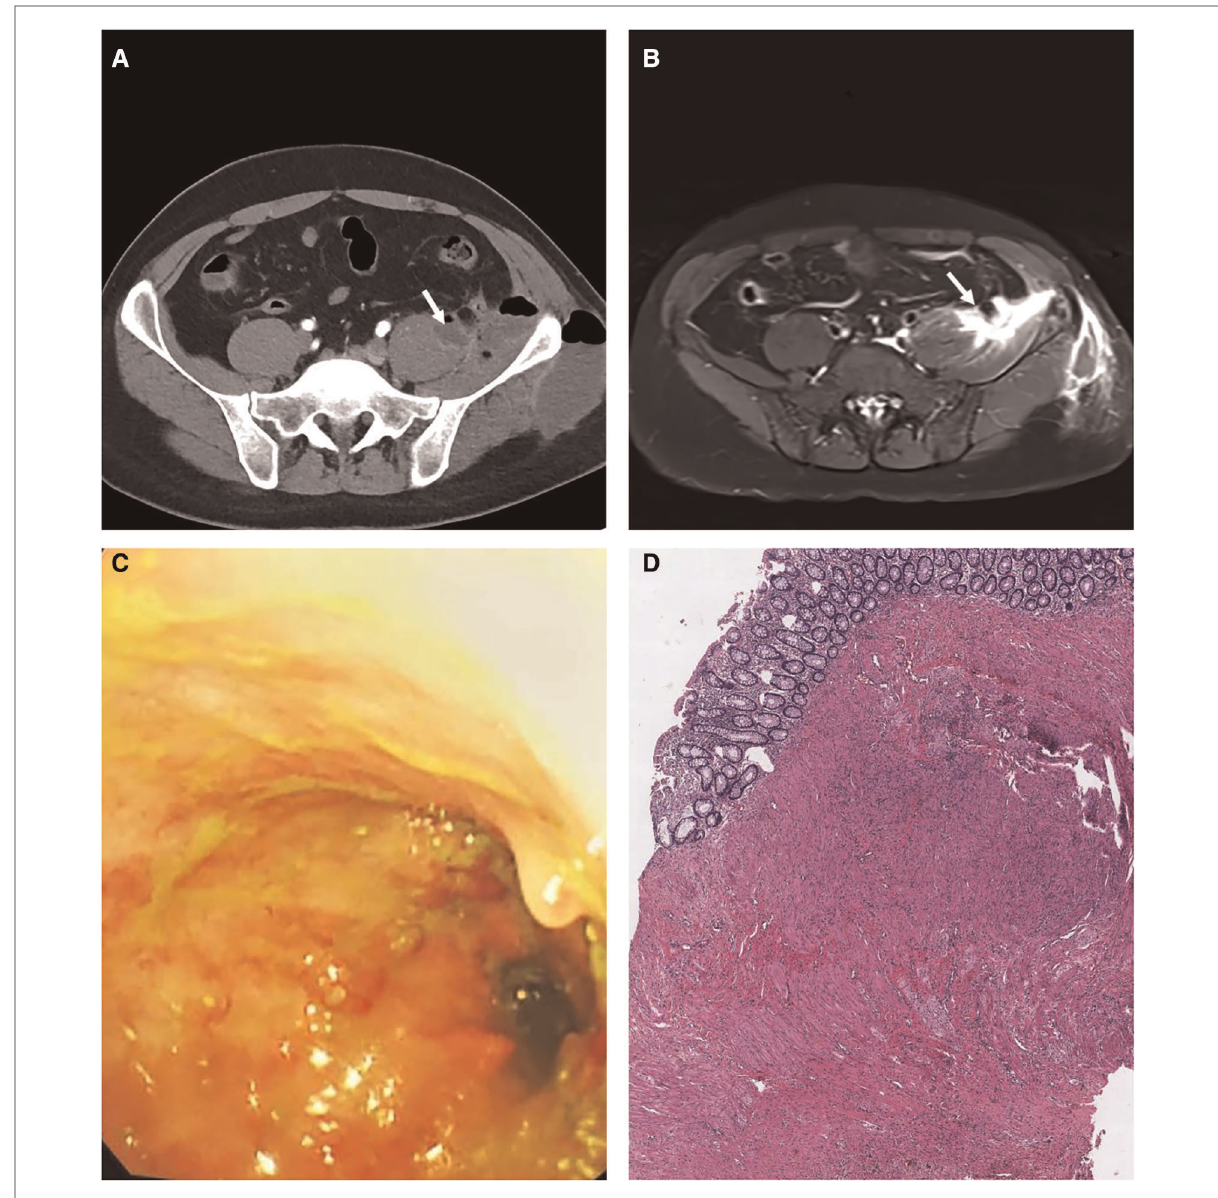
FIGURE 1 The abdominal CT showed patchy low-density shadow of the left pelvic wall soft tissue ( A ). The pelvic MRI showed that the lower part of the left psoas major muscle, the left pelvic wall and the left buttock were thickened with multiple high signal shadows ( B ). Colonoscopy showed multiple fi lling defects and local lumen stenosis in the terminal ileum, ileocecum and the beginning of the ascending colon ( C ). The pathological results revealed that a large number of proliferative ganglion cells and circuitous hyperplastic nerve fi bers were found in the submucosa and muscular layer of the colon wall ( D